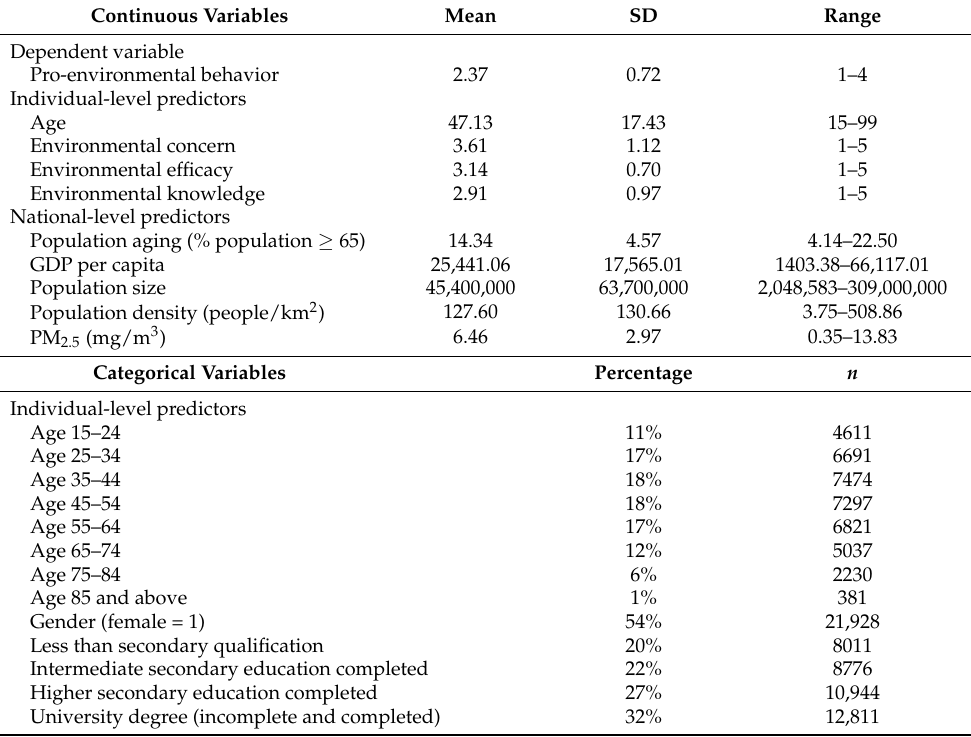
Table 2. Descriptive